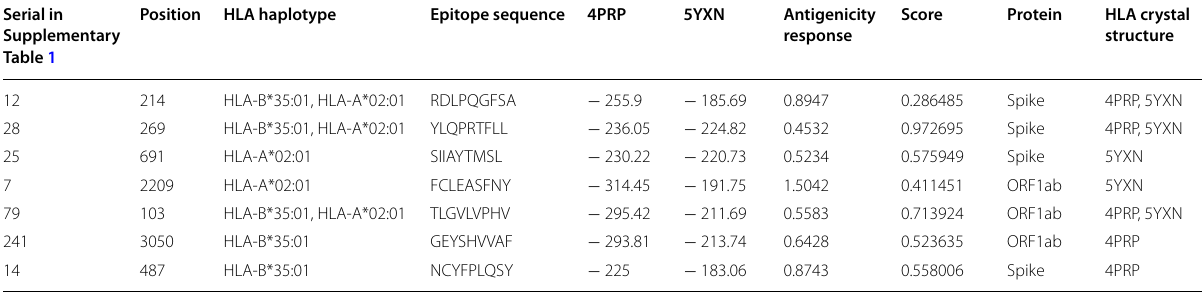
Table 1 The candidate SARS‑CoV‑2 epitopes for the Egyptian most frequent alleles of MHC class I molecules Position HLA Serial in Supplementary